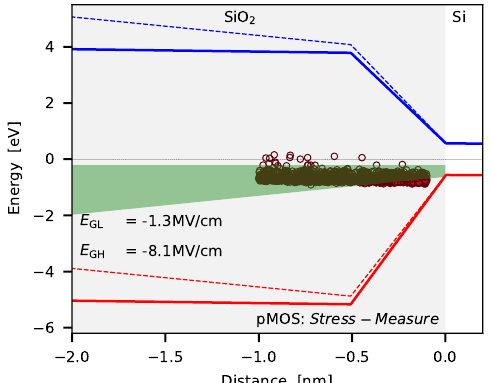
Figure 3. The band-diagram of a pMOS transistor is shown with a possible trap band of defects being responsible for the drift of the threshold voltage when negative BTI (NBTI) is considered. Also shown is the active energy region (AER, green area) for charge trapping which defines the energetic area of the defects which can contribute to the measurement signal at given bias conditions. The transition region shown in the band-diagram between the Si bulk material and the insulator which is in accordance with ab-initio calculations [56–58]. Quite recently, BTI in various technologies has been successfully explain using the modified band-structure